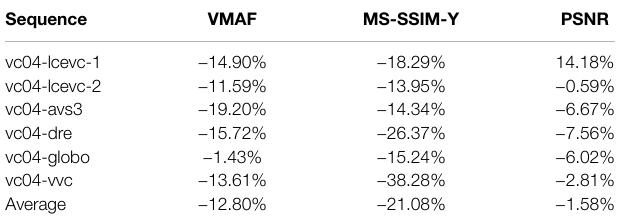
TABLE 9 | BD-rate savings for LCEVC-enhanced x265 over x265 (PQ). VMAF